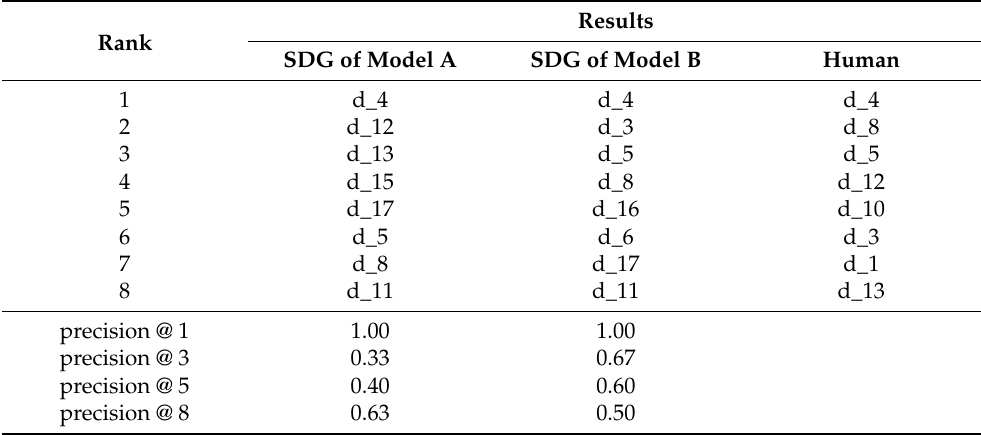
Table 2. Ranking results of Model A and Model B as well as human evaluation for median cognitive diversity case.